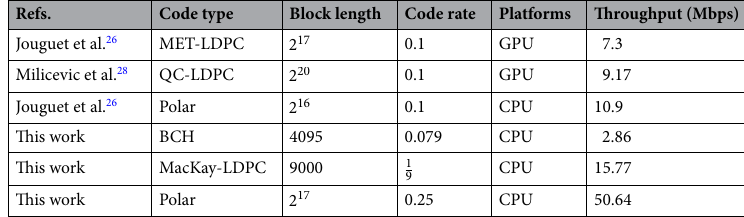
Table 5. Throughput comparison with QKD by different type of error correction codes.